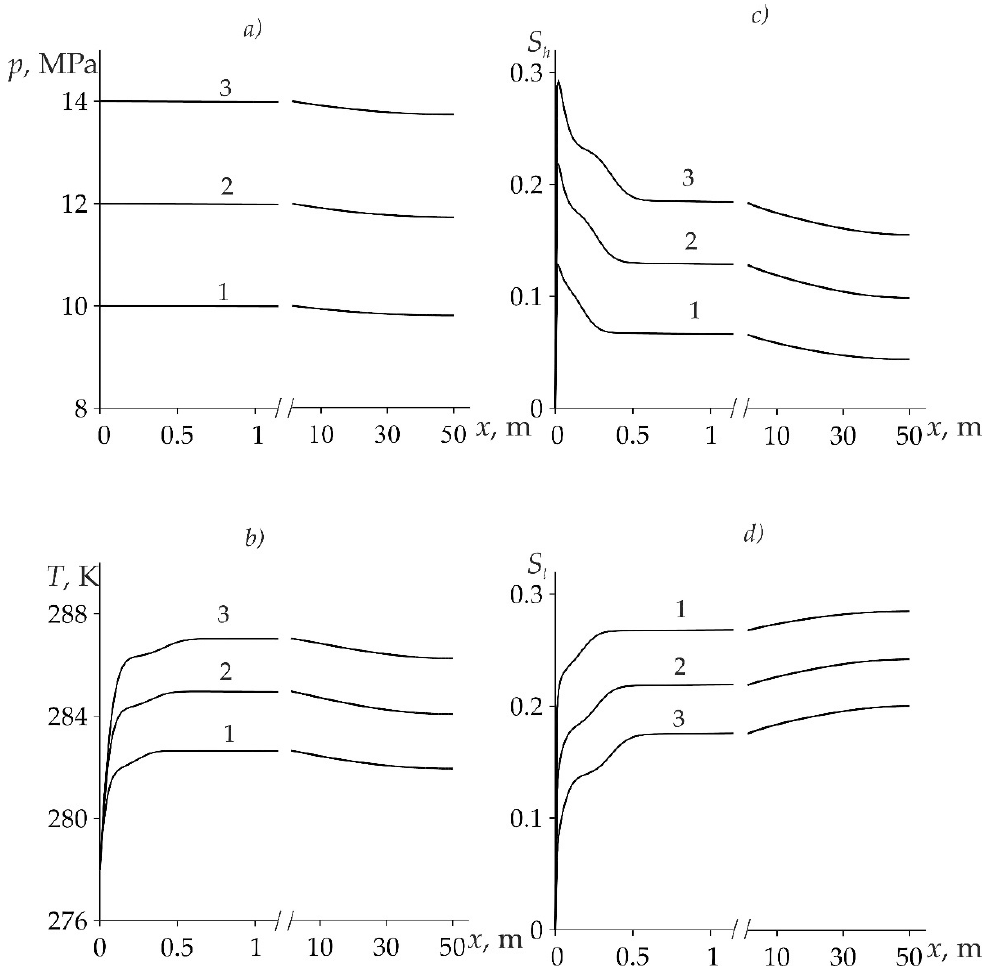
Figure 1. Distributions of pressure ( a ), temperature ( b ), hydrate saturation ( c ) and water saturation ( d ) at: p w = 10 MPa (1), 12 MPa (2), 14 MPa